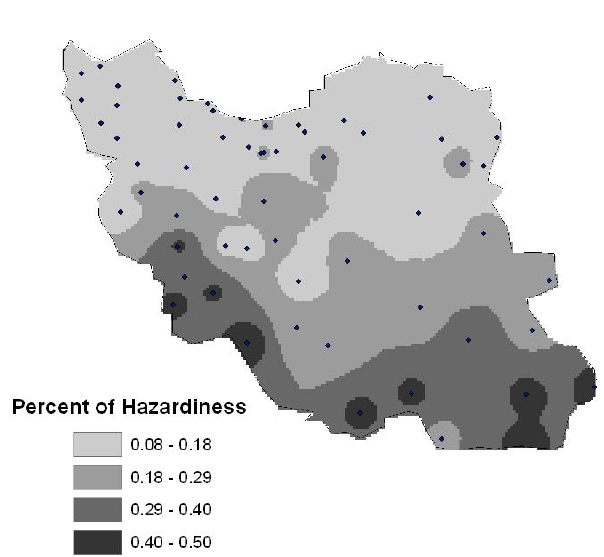
Figure 3. Spatial variation of climate hazard in